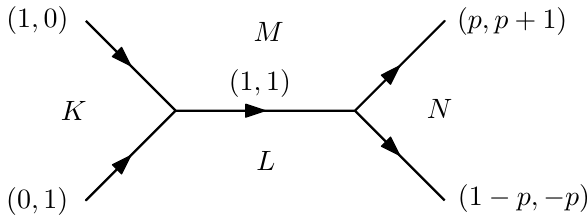
Figure 6. By SL(2 ; Z ) transformation, one can put diagram 5 to this form where parameter p is given by combination